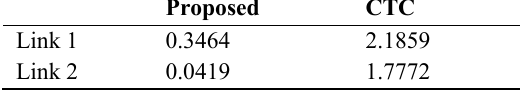
Performance of controllers under uncertainty